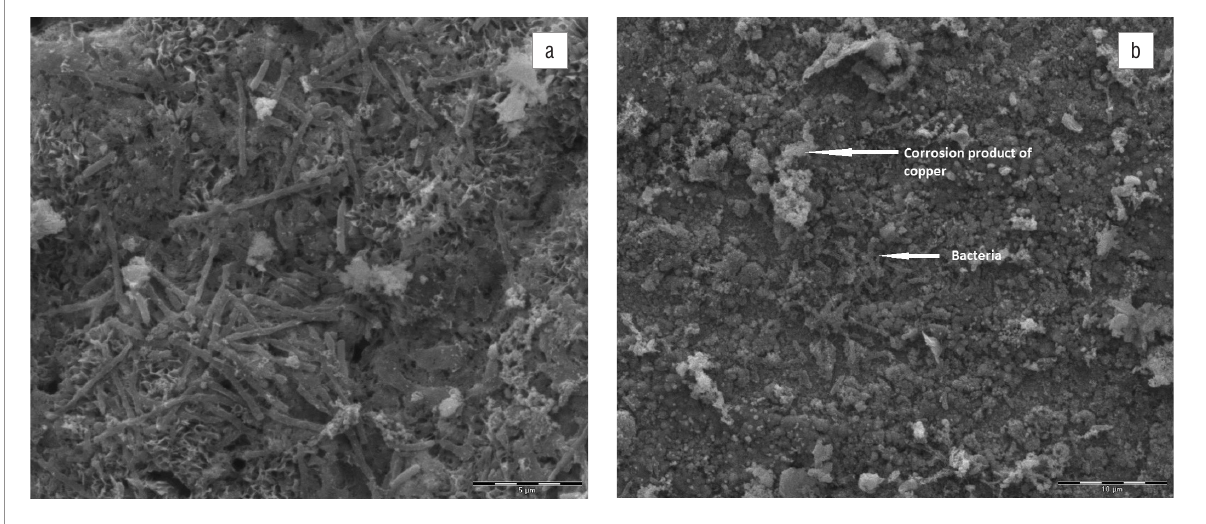
Figure 4: Electron micrographs of biofilm from mixed water collected using (a) galvanised coupons or (b) copper